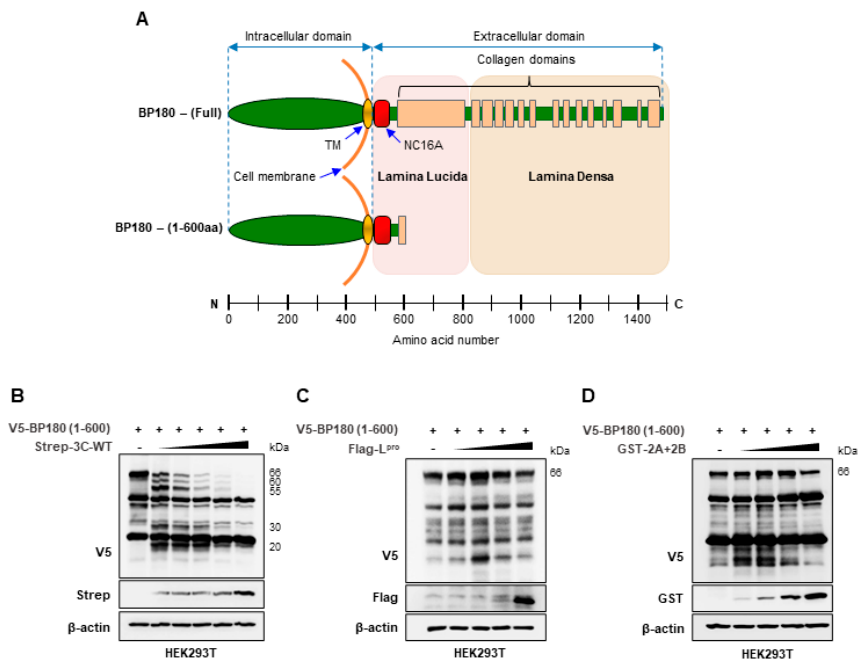
Figure 1. FMDV 3C pro cleaves and degrades BP180: ( A ) Diagram illustrating the domain mapping of BP180; ( B – D ) Respective immunoblotting of BP180 cleavage and degradation with FMDV proteases. The HEK293T cells were cotransfected with V5–tagged BP180 (1 − 600 aa) plasmid (1.5 µg) along with the control plasmid or increasing amounts of ( B ) Strep–tagged FMDV 3C pro wild–type plasmid (10, 20, 40, 80, and 160 ng), ( C ) FLAG–tagged FMDV L pro plasmid (100, 200, 400, and 800 ng), or ( D ) GST–tagged FMDV 2A+2B plasmids (100, 200, 400, and 800 ng) on a 6–well plate. Samples were collected at 30 h post–transfection and cell lysates were immunoblotted with V5, Strep, FLAG, GST, and β –actin antibodies based on the tagging of the transfected plasmids. All of the data represent 3